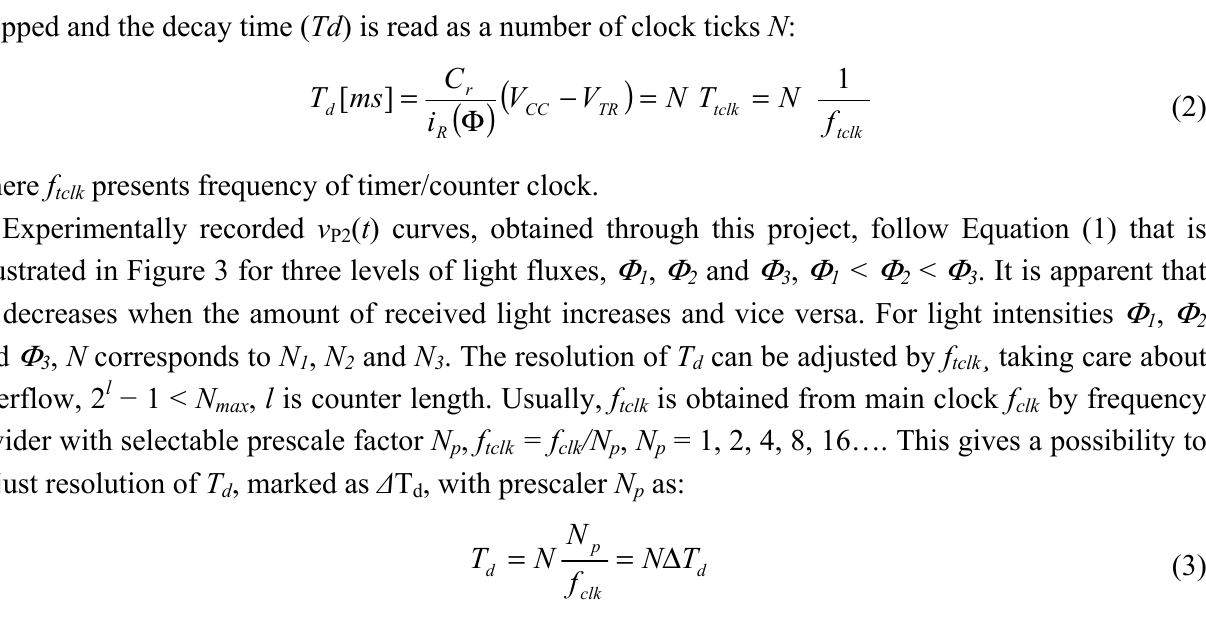
Figure 3. The processes of LED discharging for different Φ